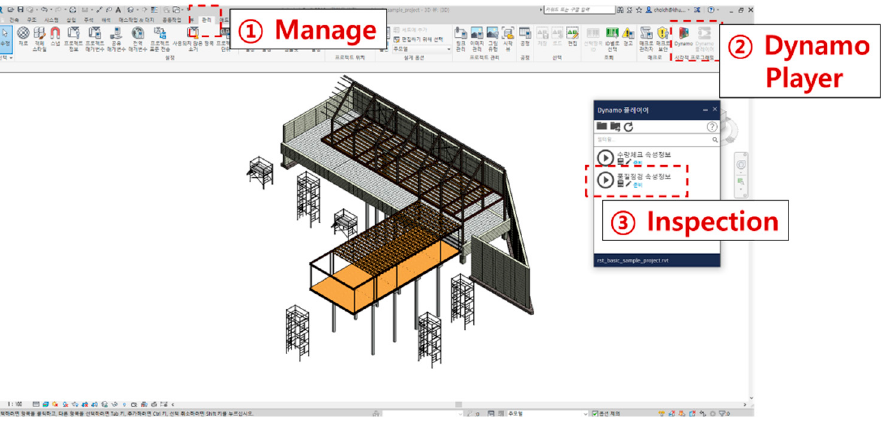
Figure 12. Automatic extraction of the attribute information pertaining to temporary facilities for the quality inspection using Dynamo.